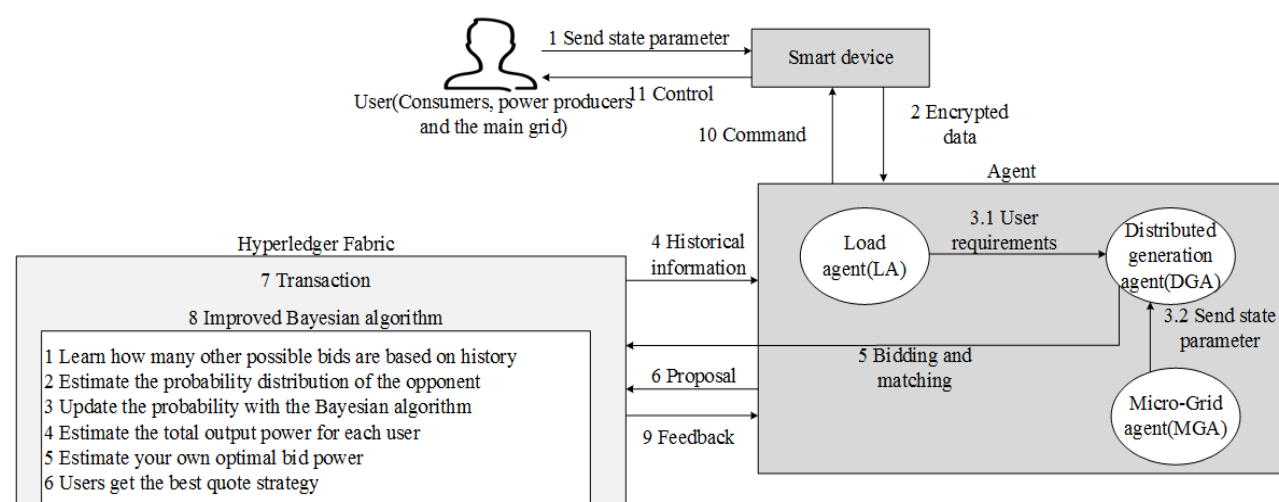
Figure 29. Reconstruction diagram of reference [58].